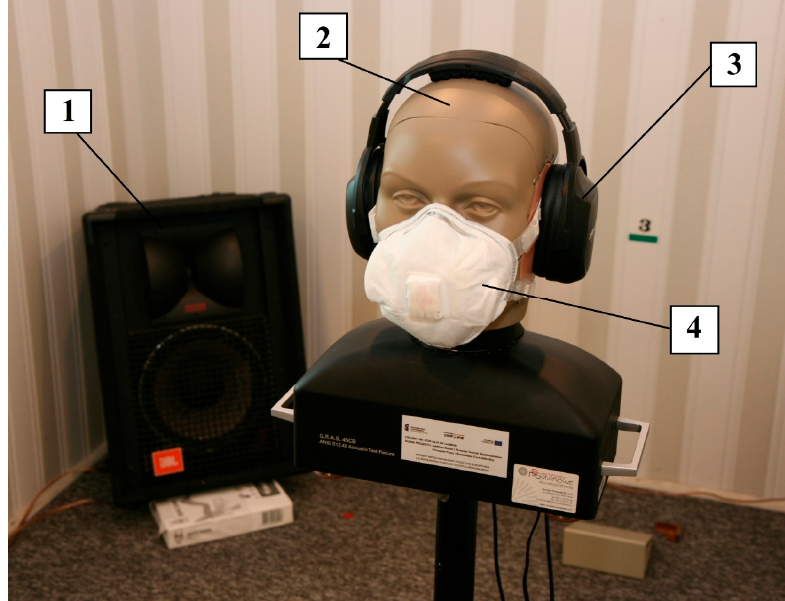
Figure 3. Measuring setup used for measurements of sound pressure level (SPL) under the earmuffs worn in combination with OPPE: 1—one of the four speaker sets, 2—acoustic test fixture, 3—tested earmuffs, 4—example of OPPE.